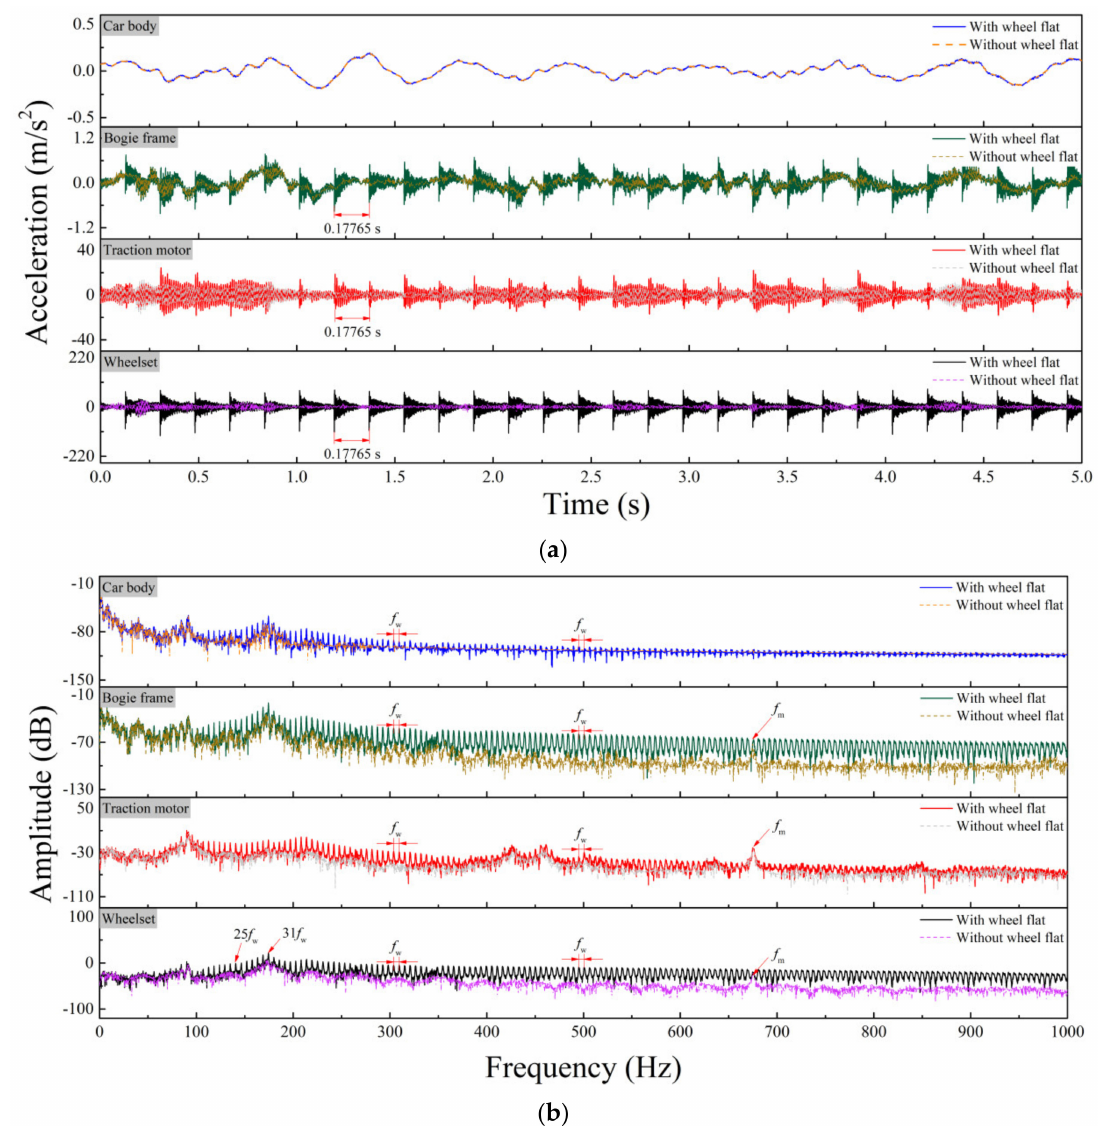
Figure 7. Vibration responses of the locomotive subsystem: ( a ) time − histories and ( b ) frequency spectrum.